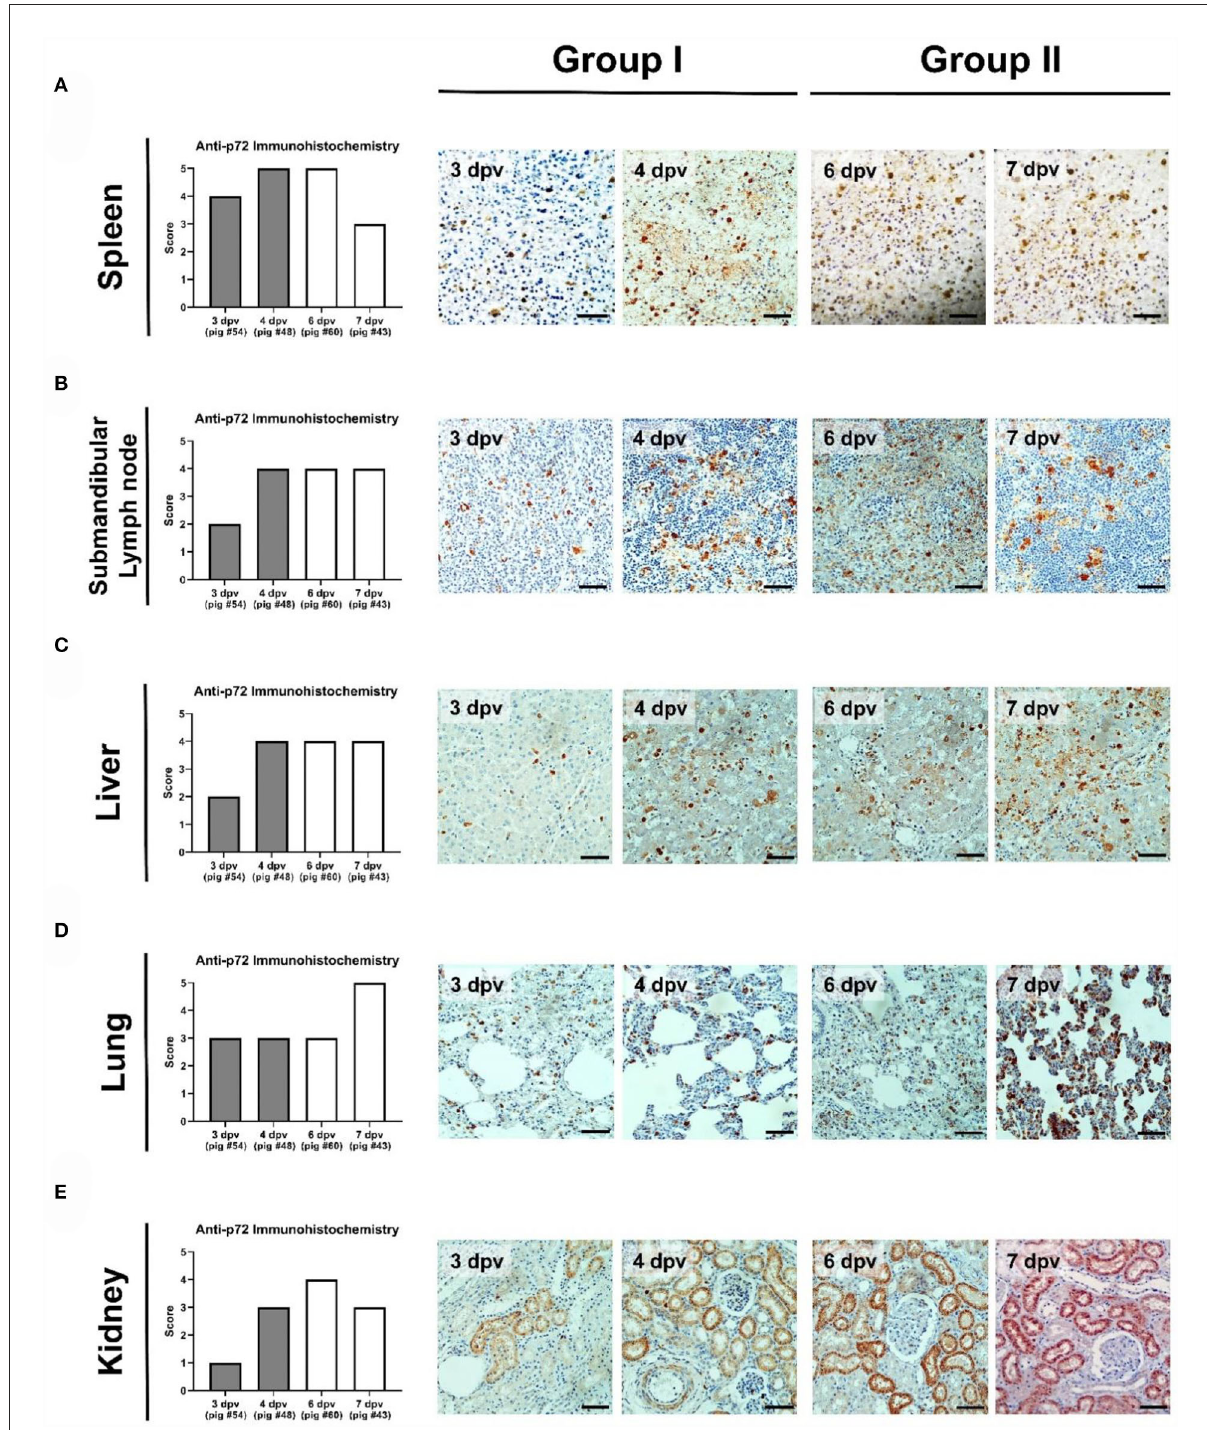
FIGURE7 Immunohistochemical analysis of p72 in the organs of pigs experimentally infected with African swine fever virus. (A) Spleen, (B) submandibular lymph nodes, (C) liver, (D) lungs, and (E) kidneys scored according to the proportion of positively stained mononuclear cells or macrophages in three fields under × 400 magnification. No positive cells (0), 1–10 positive cells (1), 11–20 positive cells (2), 21–30 positive cells (3), 31–40 positive cells (4), ≥ 41 positive cells (5). Scale bar, 50 µ